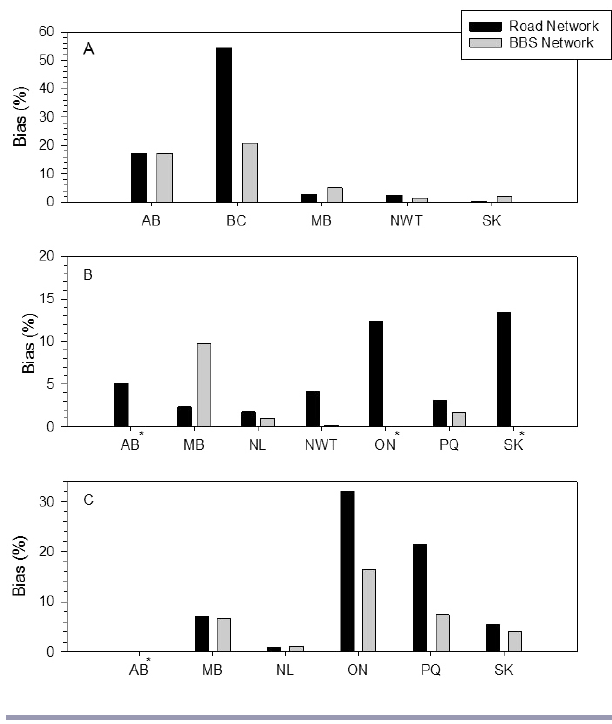
Fig. 5 . Overall bias in representation of anthropogenic disturbances along North American Breeding Bird Survey (BBS) routes compared against proportion of the BBS strata comprised of anthropogenic disturbances (circa 2008-2010) within the full BBS network and the road network as a whole in (A) bird conservation area 6 (BCR 6; Boreal Plains), (B) BCR 7 (Taiga Shield and Hudson Plains), and (C) BCR 8 (Boreal Softwood Shield). An asterisk (*) indicates that missing BBS network bars are because of no BBS coverage within the associated stratum and not zero